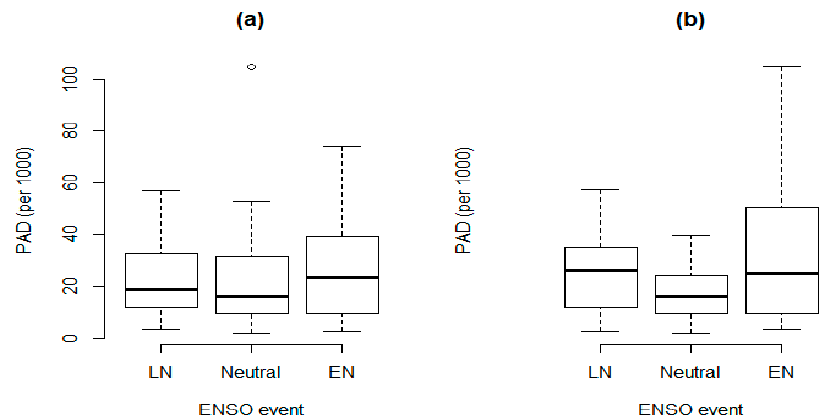
Figure A1. Global PAD rates by El Niño (EN), La Niña (LN) and neutral years, 1964–2017. EN, LN or neutral years defined as ( a ) type 1 events beginning in the second half of the previous year and ending in the first half of the same year as the disaster year; and ( b ) type 2 events beginning in the second half of the same year as the disaster year and ending in the first half of the following year. Events: ONI > 0.5 °C (for EN) or < − 0.5 °C (for LN), otherwise neutral in five consecutive three-months overlapping seasons.